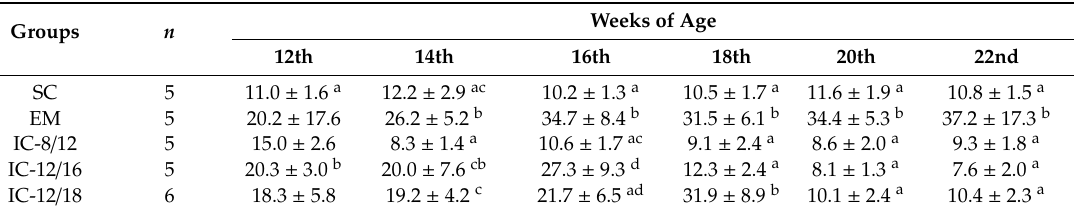
Table 2. Fecal testosterone concentration (ng / mL) (mean ± SD) within groups SC, EM IC-8 / 12, IC-12 / 16, and IC-12 / 18 from 12th to 22nd week of